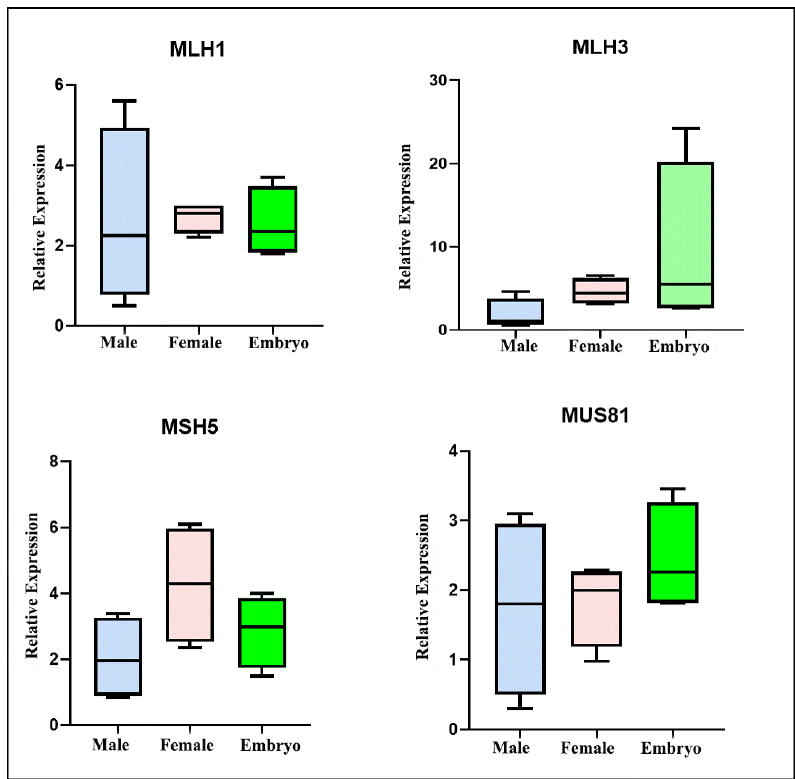
Figure 7. Relative expression of mismatch repair genes and MUS81 in gonads and embryos of T. silvestris (2n = 24). Expression values were obtained using the transcription of beta-actin gene as normalizer.